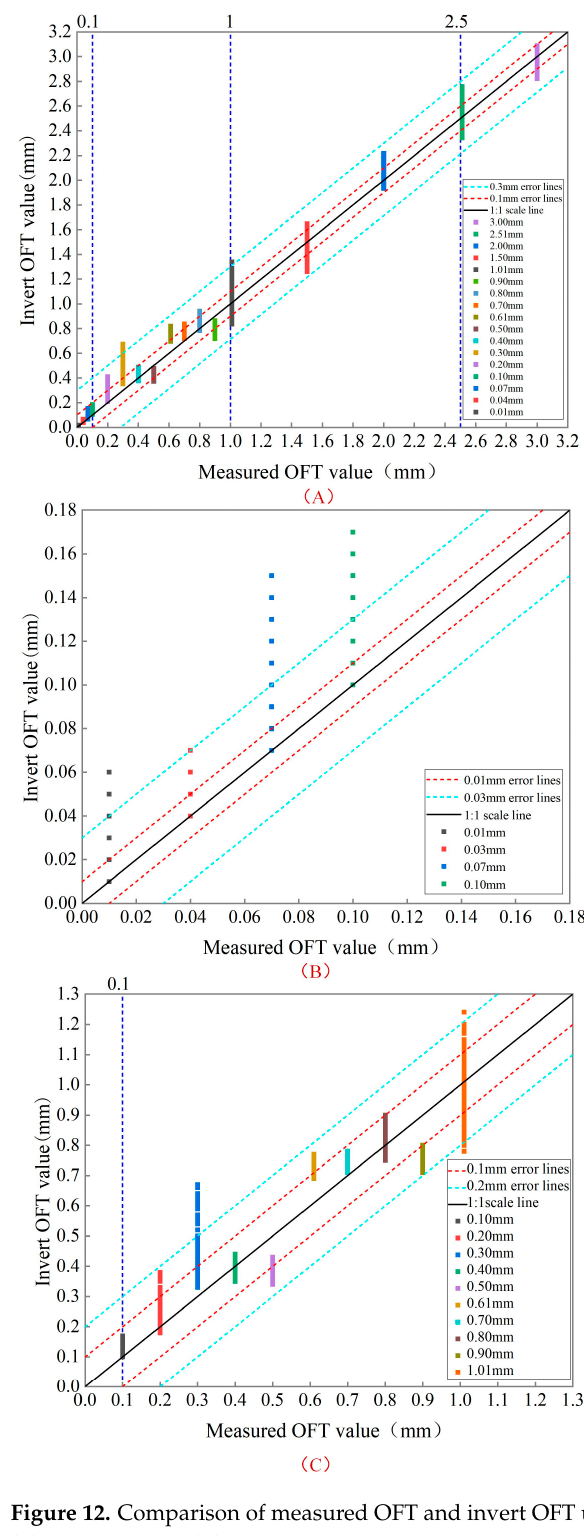
Figure 12. Comparison of measured OFT and invert OFT under summer dataset: ( A ) 0.01–3.00 mm;